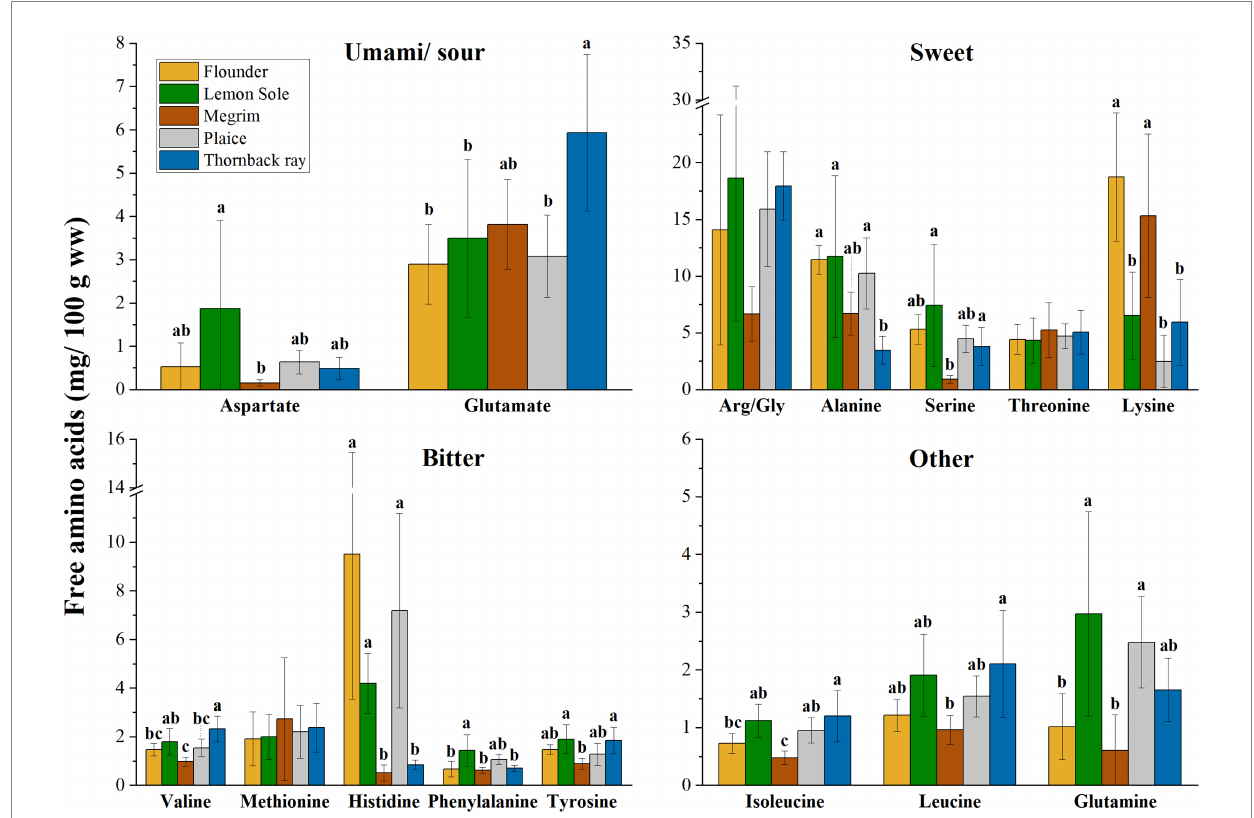
FIGURE 2 Free amino acids (FAA) in mg/100 g sample (ww), distribution grouped in taste perceptions umami/sour, sweet, bitter, and other. Error bars show SD. ANOVA was applied on species and each FAA; where significant difference between species was detected ( α < 0.05), a Tukey HSD post hoc test was applied. Values with different letters (a, b) are significantly different ( p < 0.05). Asparagine is not displayed due to shallow contents (>0.1 mg/100